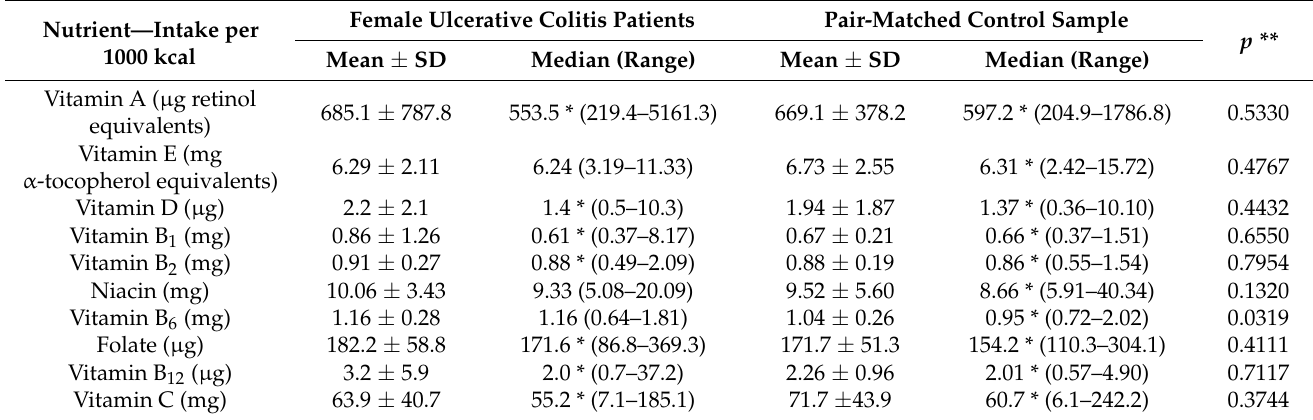
Table 6. The vitamins intake recalculated per 1000 kcal in the studied Polish female ulcerative colitis individuals, in comparison with a pair-matched control